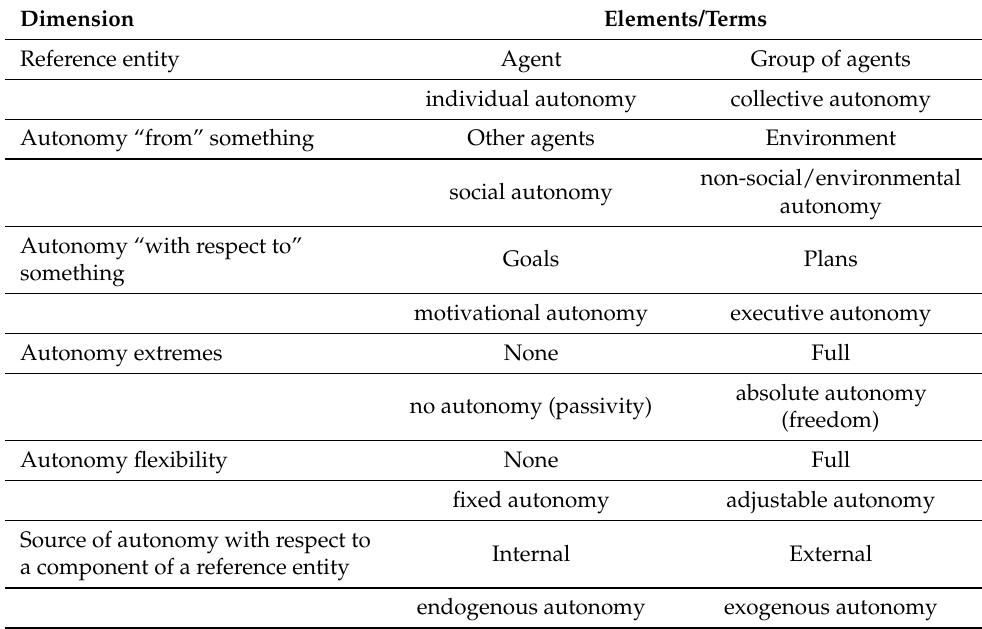
Table 1. A summary of common notions of autonomy.